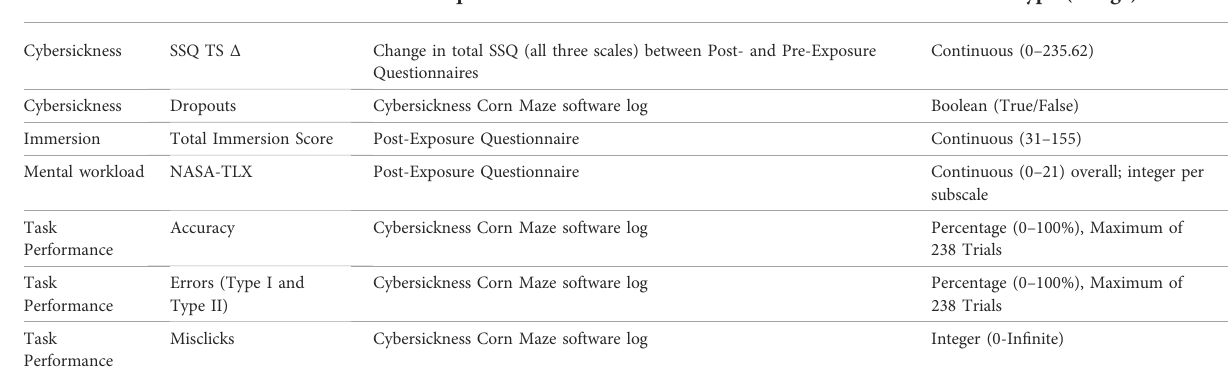
TABLE 1 Dependent variables.